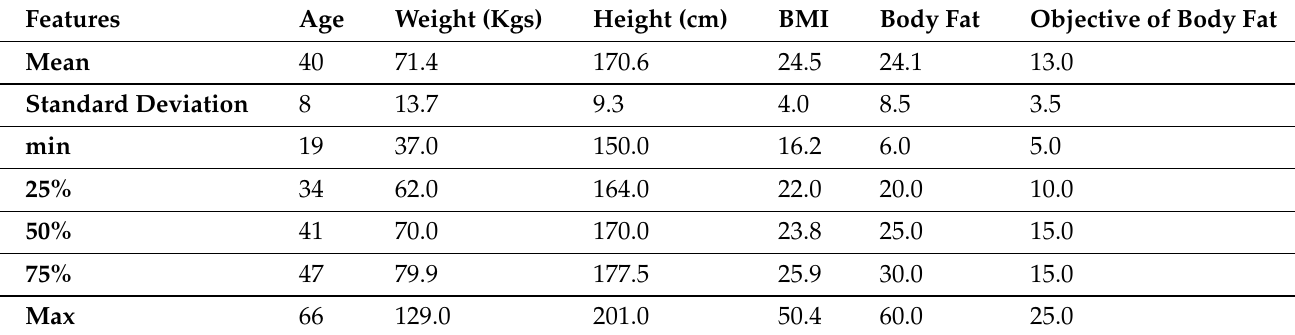
Table 2. Characteristics of the participants who met the inclusion criteria.